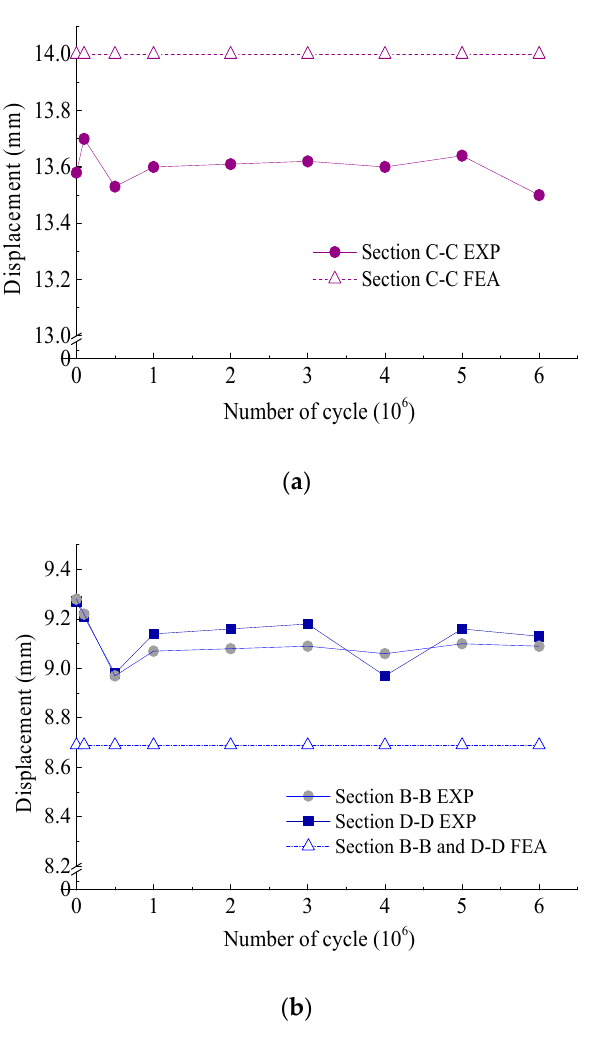
Figure 13. Displacement versus cycles: ( a ) section B-B and section D-D; ( b ) section C-C. “EXP” represents experimental result, and “FEA” represents finite element analysis result.